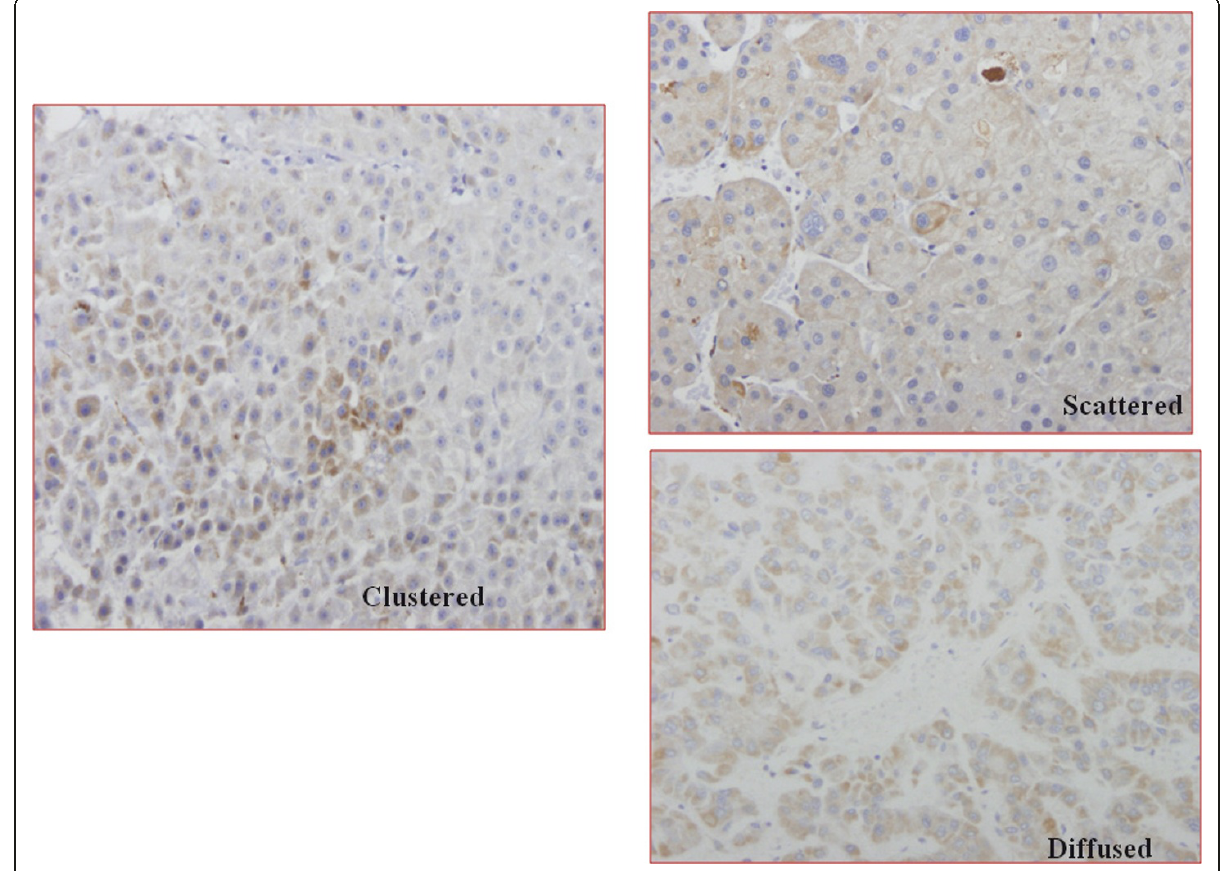
Figure 1 Pattern of hepatic SCCA immunostaining in HCC